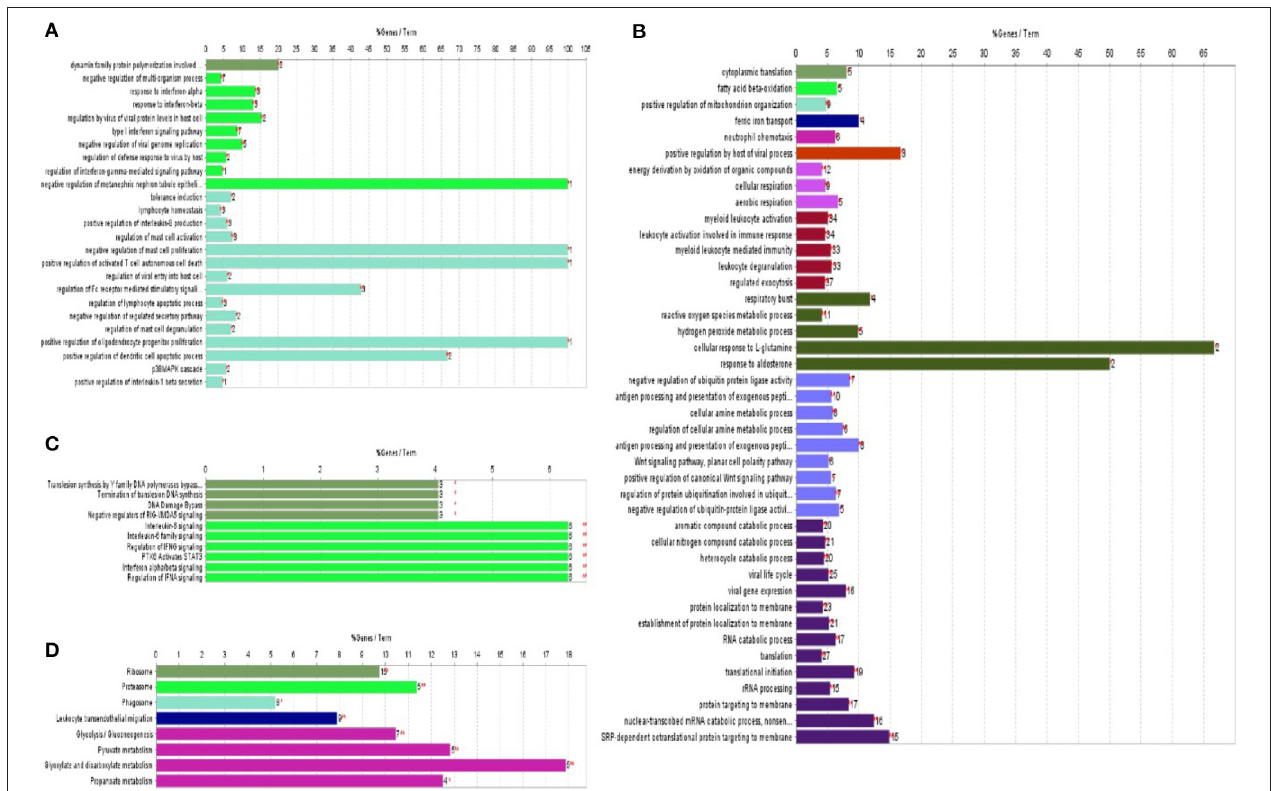
FIGURE 3 | ClueGo was applied to enrich the biological process and KEGG pathways of significantly differentially expressed proteins identified in HP-PRRSV HN07-1-infected PAMs. (A) Biological process enrichment terms of significantly up-regulated proteins. (B) Biological process enrichment terms of significantly down-regulated proteins. (C) KEGG pathway enrichment terms of significantly up-regulated proteins. (D) KEGG pathway enrichment terms of significantly down-regulated proteins. The same color indicates similar functional categories. * P < 0.05, ** P < 0.01. More information can be found in Supplementary Tables 8–11